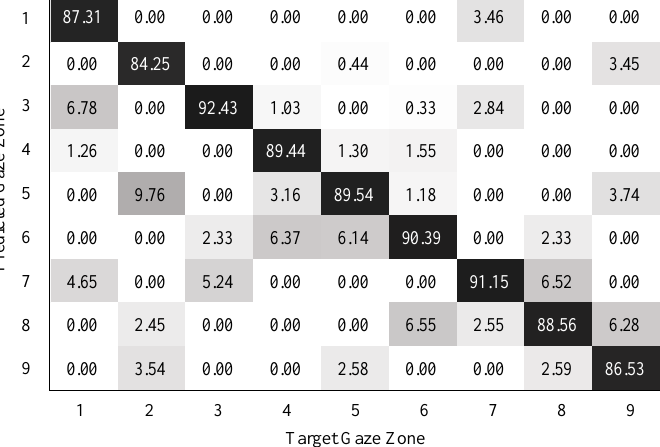
Figure 12. Gaze zone classification results based on the PointNetLK method and SVM classifier.